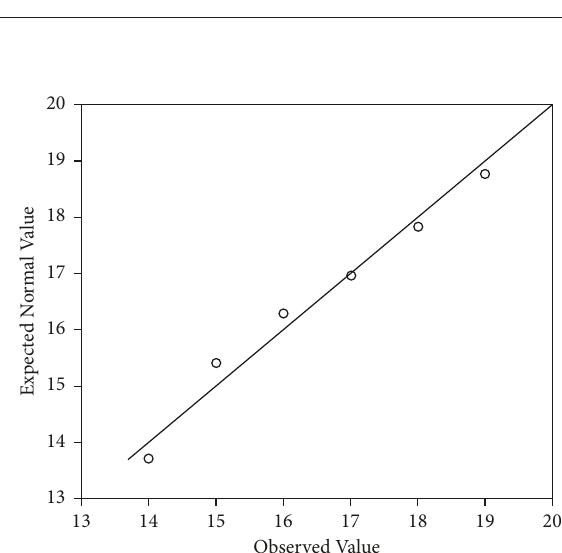
Figure 3: Graphic indicator of strategy use surveys’ normality.